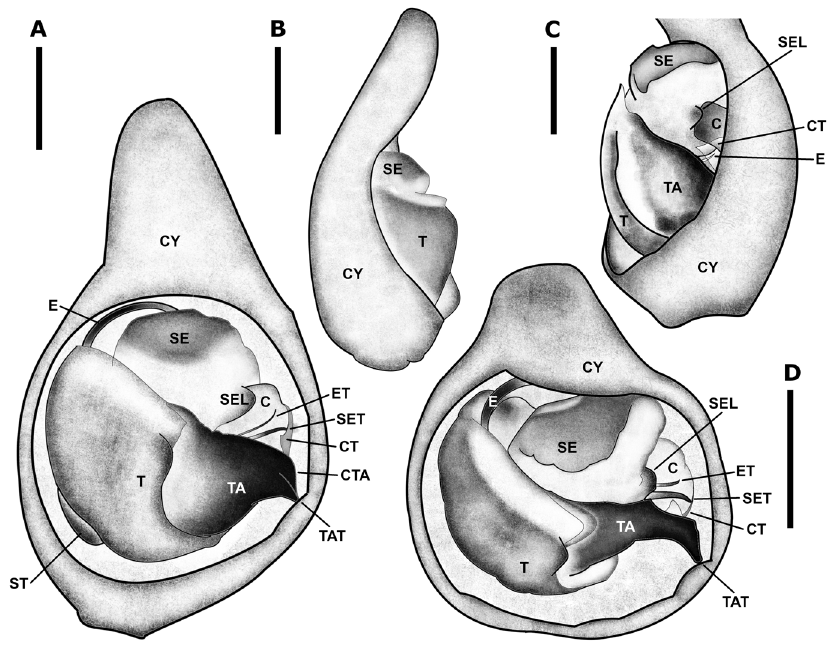
Fig. 20. Lycosa gesserit sp. nov., holotype, ♂ (HUJ INV-AR20631), left pedipalp line drawings. A . Ventral view. B . Prolateral view. C . Retrolateral view. D . Distal view. Scale bars = 0.5 mm. Drawings by I. Armiach